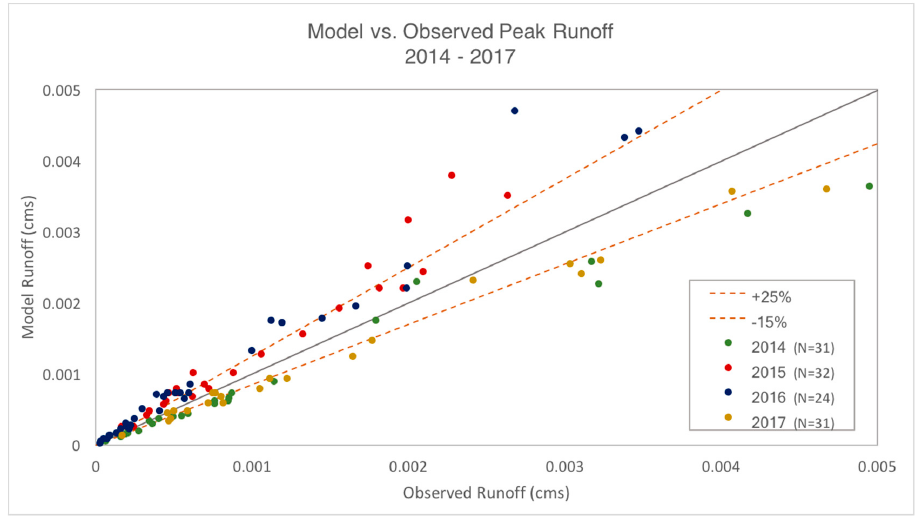
Figure 8. Model vs. observed peak runo ff validation envelope (+25% to − 15%).